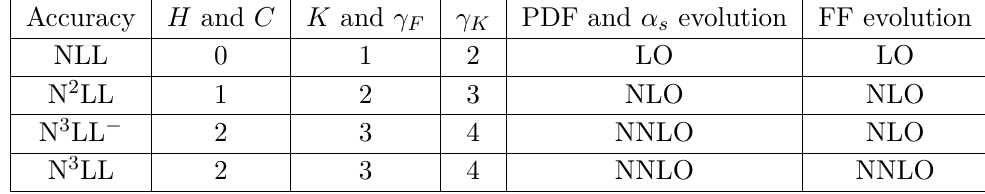
Table 1 . Truncation orders in the expansions of the perturbative ingredients of TMDs relevant to the logarithmic counting considered in this paper (see text). The last column refers to the order used for the evolution of the collinear